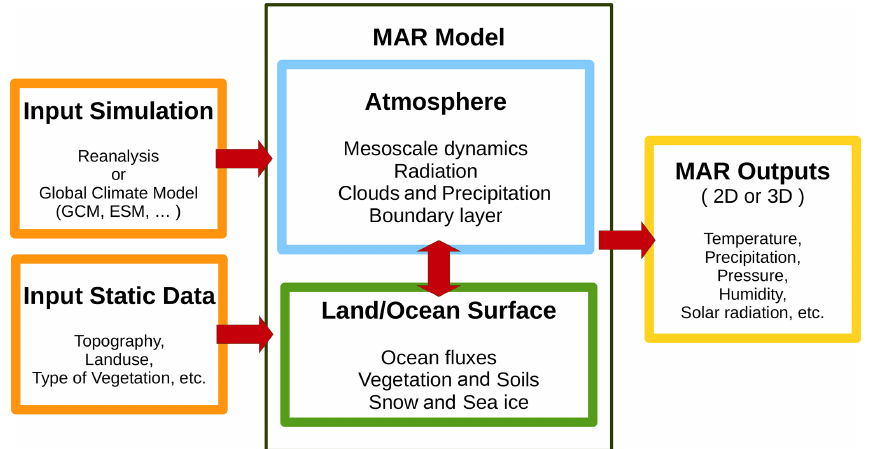
Figure 1. Workflow of the MAR model. The MAR model (black box) needs to be forced by a reanalysis model or global model (upper orange box) and by static data (lower orange box). The result of the MAR simulation gives meteorological variables in two or three dimensions (yellow box).